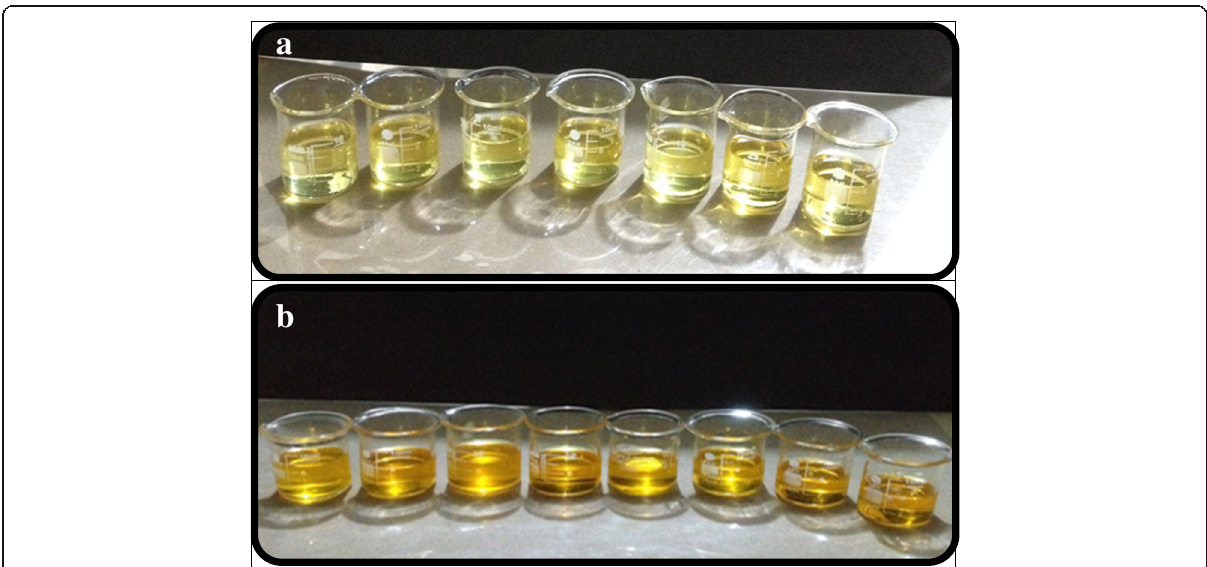
Fig. 7 Results of dye test; upper picture ( a ) representing candesartan cilexetil nanoemulsion formulations before adding methyl orange dye ( water soluble ) and the lower picture ( b ) showing the homogenous miscibility of the dye with nanoemulsions